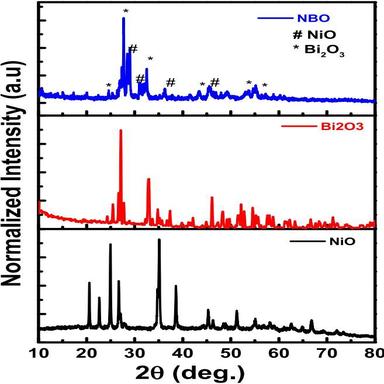
Powder XRD patterns of pure NiO, Bi2O3 materials and NBO composite material.